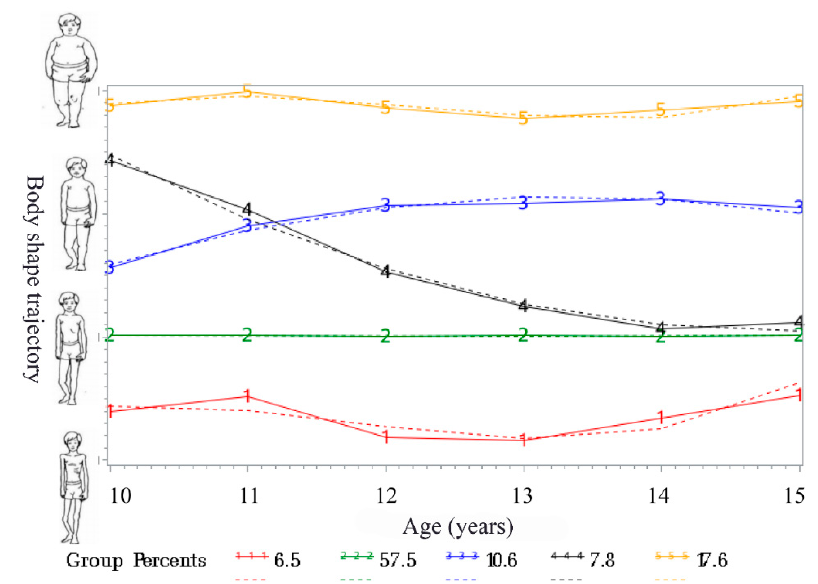
Figure 1. Trajectories of body shape during adolescence from 10–15 years. Solid lines represent observed values, and dashed lines represent expected values. Group 1, “persistent underweight” (6.5%); Group 2, “persistent healthy weight” (57.5%); Group 3, “progressive overweight” (10.6%); Group 4, “obesity to healthy weight” (7.8%); Group 5, “progressive obesity” (17.6%). Table 1. Participant characteristics for each of the five different body mass index trajectory groups.